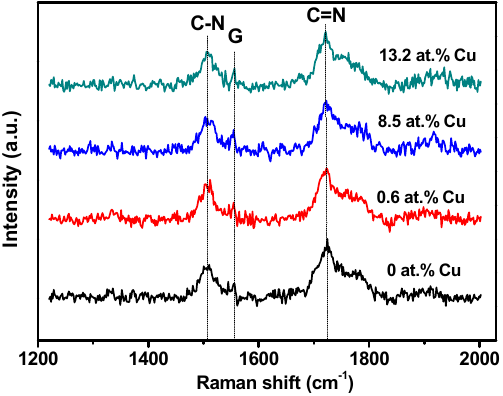
Figure 2. Raman Patterns of VCN–Cu composited films with different Cu contents.